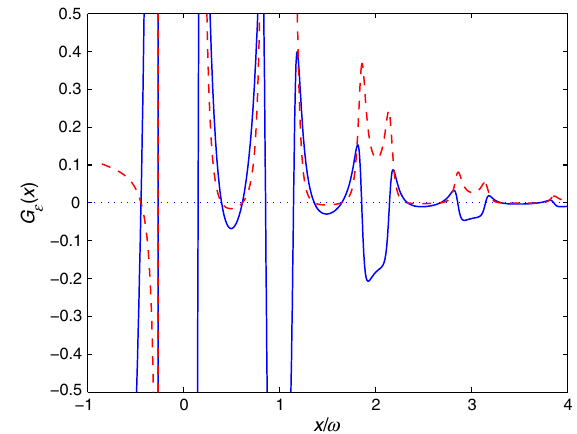
FIG. 1. Transcendental function G ϵ ð x Þ for ϵ ≠ 0 . The param- eters are ω ¼ 1 , g ¼ 0 . 1 , λ ¼ 0 . 5 , Δ ¼ 0 . 4 , ϵ ¼ 0 . 2 , and θ ¼ − π = 2 ; the zero points whose real (solid blue line) and imaginary parts (dashed red line) of G ϵ both equal 0 correspond to the eigenvalues of Hamiltonian.